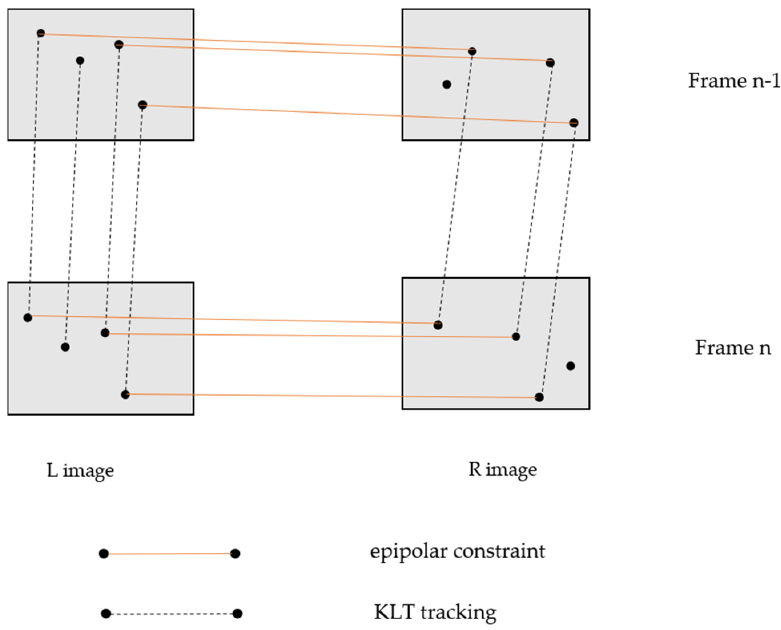
Figure 6. Schematic diagram of the feature extraction and tracking. The optical flow and epipolar constraint method are combined to track the feature points at the front and back moments in order to ensure the accuracy of the feature point association. In addition, the depth map obtained by the TOF camera is introduced to guide the feature point association. The depth map is projected to the left camera coordinate system through the joint calibration in Section 3.1. The disparity map of the TOF camera